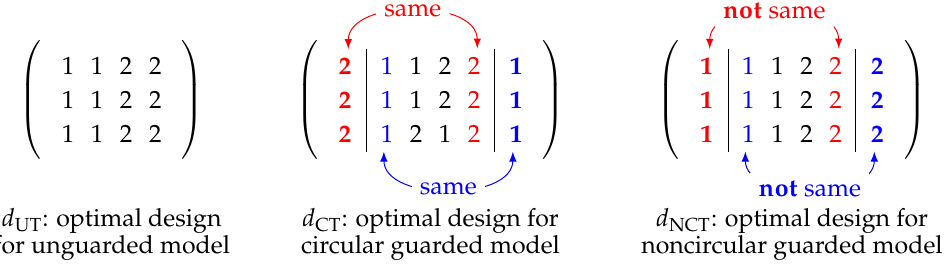
Figure 1. Optimal designs for the estimation of total effects under ( i ) unguarded setup ( left ), ( ii ) circular guarded setup ( middle ) and ( iii ) noncircular guarded setup ( right